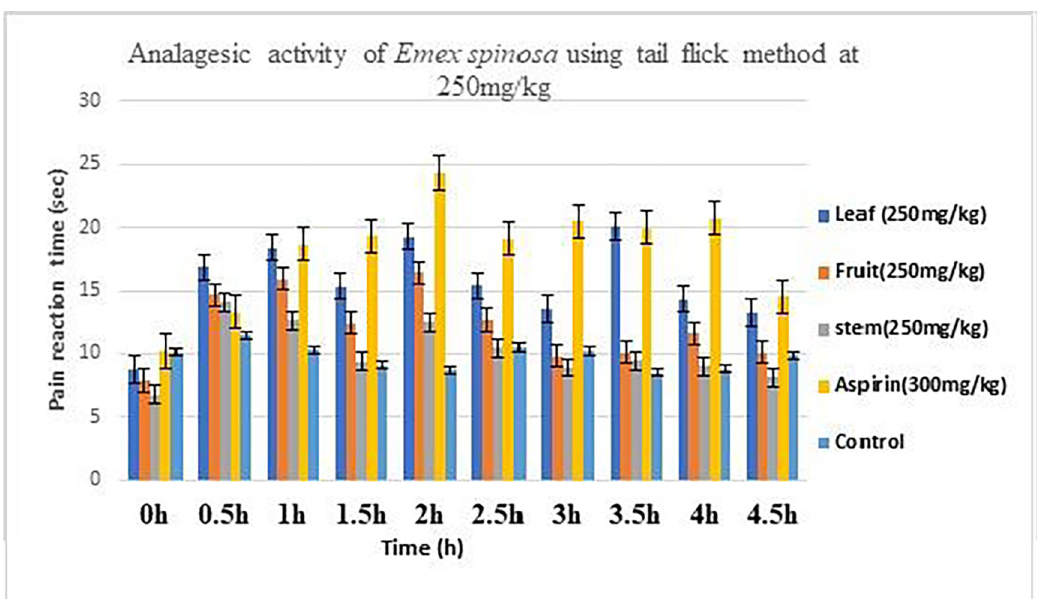
Fig 2. Analgesic activity of E . spinosa leaf, fruit, and stem collected from Bhimber AJK.